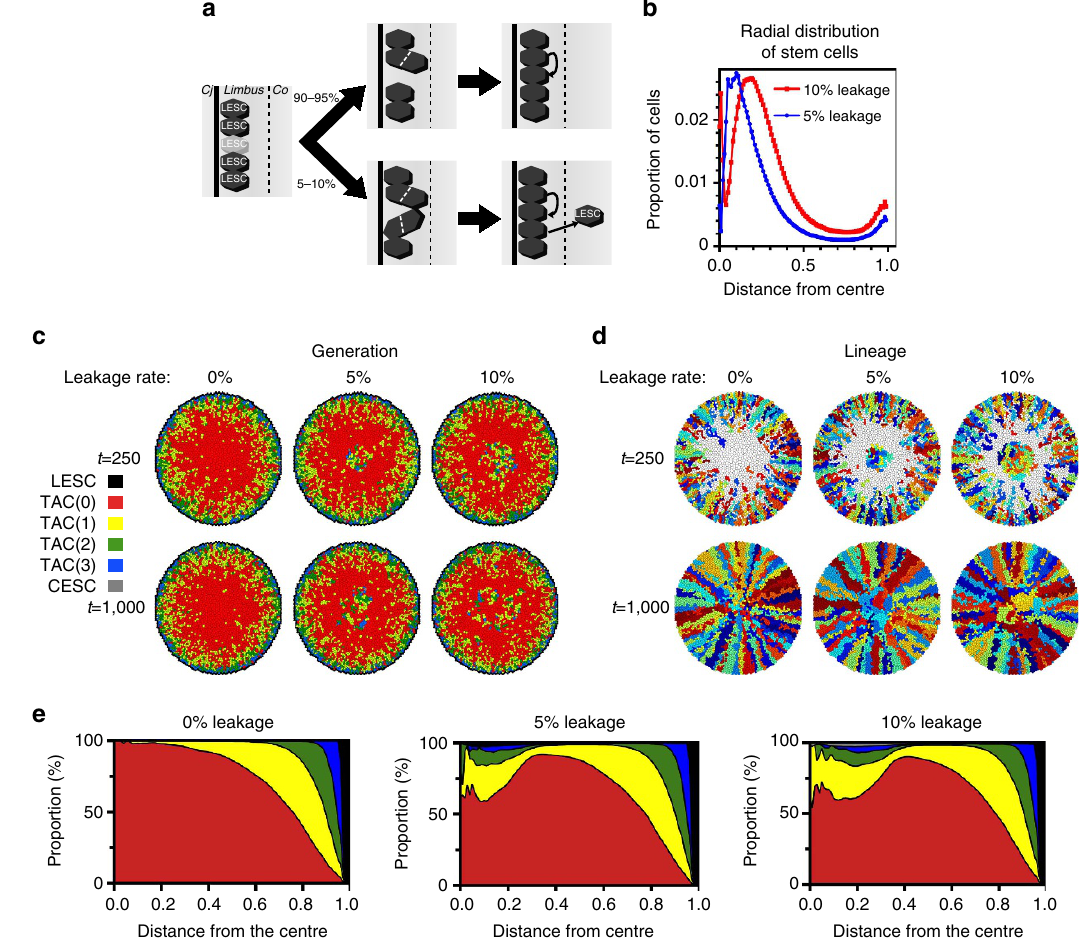
Figure 4 | Stem cells leaking from the limbus accumulate near the centre of the cornea and reduce the degree of centripetal organization of the corneal epithelium. ( a ) A scenario that might result in stem cell leakage from the limbus. The death of a LESC (left) stimulates neighbouring LESCs to replace it. Usually, only one neighbour successfully completes symmetrical cell division, leading to a one-for-one replacement (top). However, 5 or 10% of the time both neighbours respond synchronously, producing two stem cells to replace the dead cell (bottom). The excess stem cell is pushed into the cornea, becoming a CESC. Cj ¼ conjunctiva; Co ¼ cornea. ( b ) Bimodal distribution of stem cells resulting from their leakage from the limbus. The kernel density distribution plots are shown for stem cells in corneas undergoing 5% (blue) or 10% (red) leakage from the limbus. ( c ) The generation maps of three corneas, representative of 0, 5 and 10% stem cell leakage at t ¼ 250 and t ¼ 1,000, showing the accumulation of a small number of CESCs near the central cornea. ( d ) The clonal lineage maps corresponding to the generation maps in c . ( e ) Radial distribution plots of corneas at t ¼ 1,000 undergoing 0, 5 and 10% stem cell leakage. Mean proportions of each cell generation at each distance from the centre of the cornea are shown ( n ¼ 25